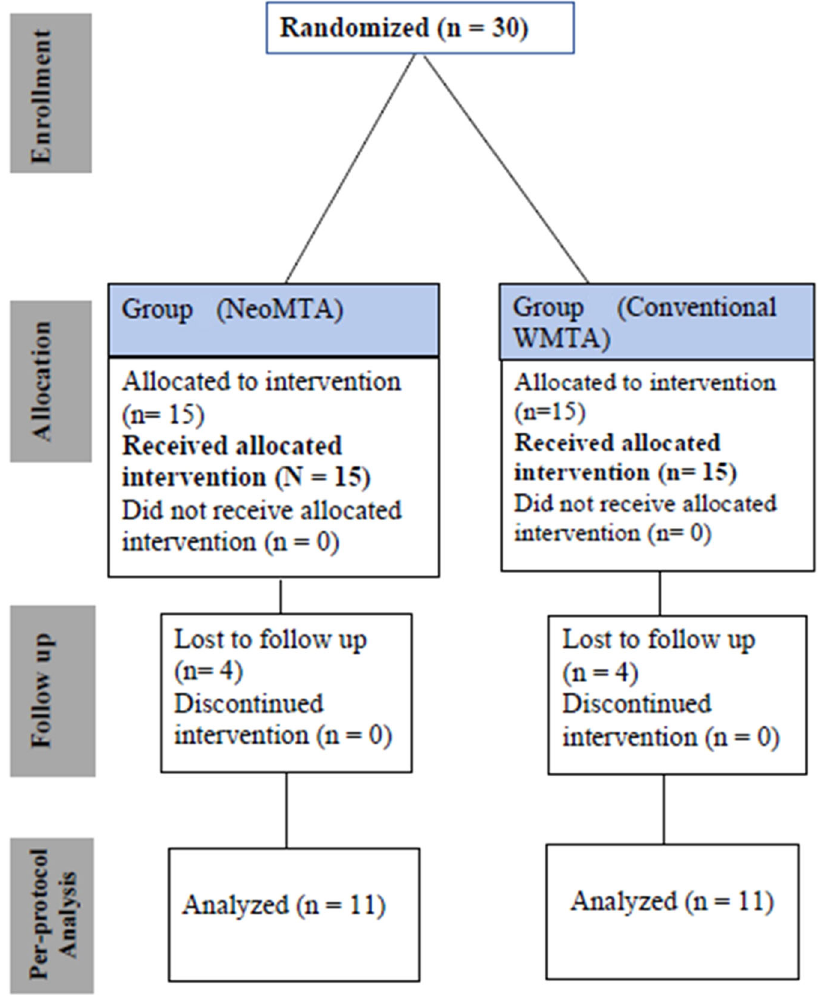
Fig. 3 Flow Chart of the study population through the study. Table 2. Age and gender distribution among study between two